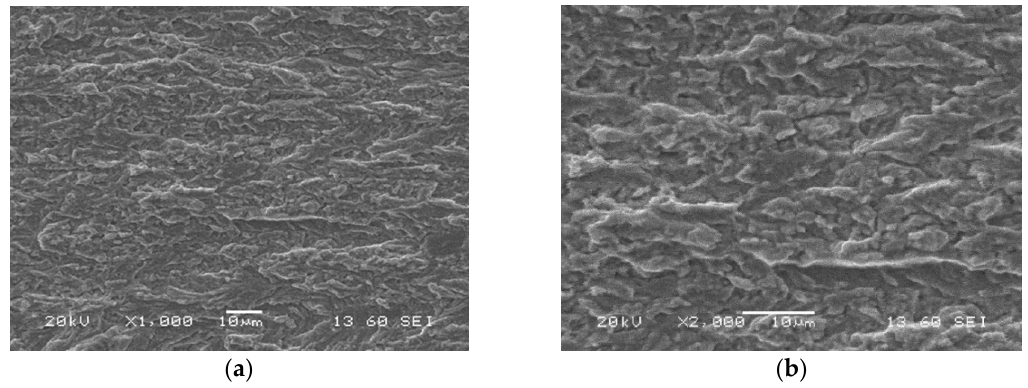
Figure 15. Microstructures of the fatigue pre-crack zone of the parent material (specimen No. 7) captured after CTOD test using SEM; magnifications: ( a ) ×1000; ( b ) ×2000.